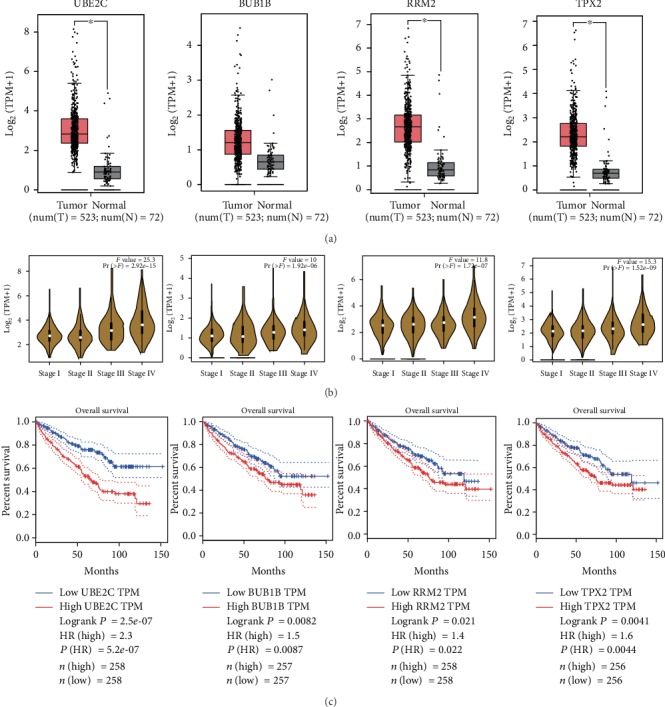
Validation of hub genes in the TCGA dataset. (a) UBE2C, BUB1B, RRM2, and TPX2 expressions in 523 KIRC patients compared with 72 normal samples. (b) Assessing hub genes' expression at different stages. (c) Overall survival curves of UBE2C, BUB1B, RRM2, and TPX2.